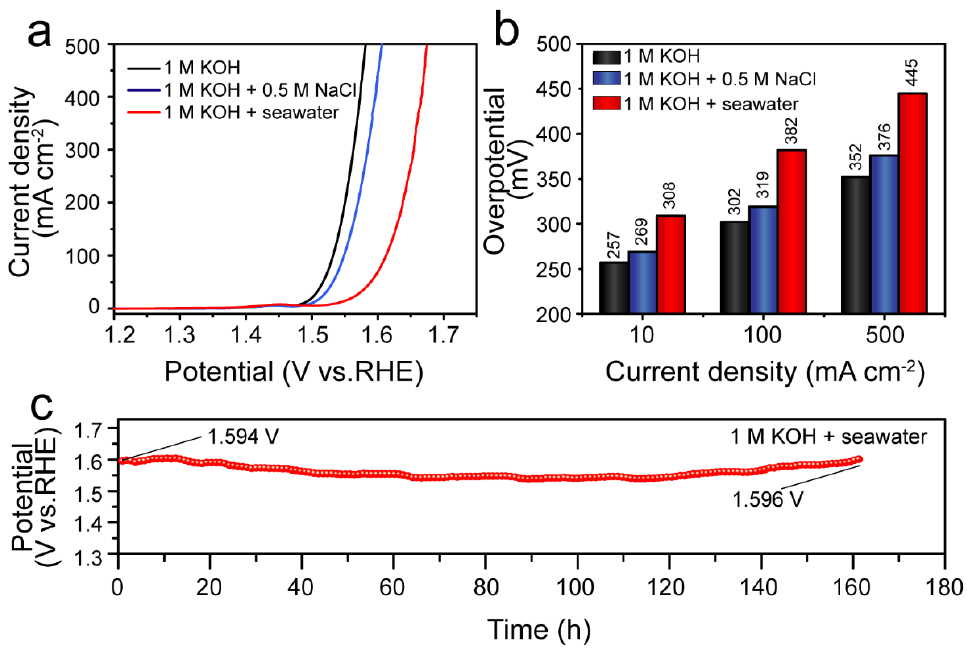
Figure 8. ( a ) LSV polarization curves of Ni 5 P 4 /Ni 2 P–FeNi@C with 85% iR-correction in different electrolytes. ( b ) The comparative overpotential values derived from the OER polarization curves at 20, 100 and 500 mA cm − 2 . ( c ) Chronopotentiometry curve of Ni 5 P 4 /Ni 2 P–FeNi@C at 20 mA cm − 2 in a 1 M KOH + seawater electrolyte.